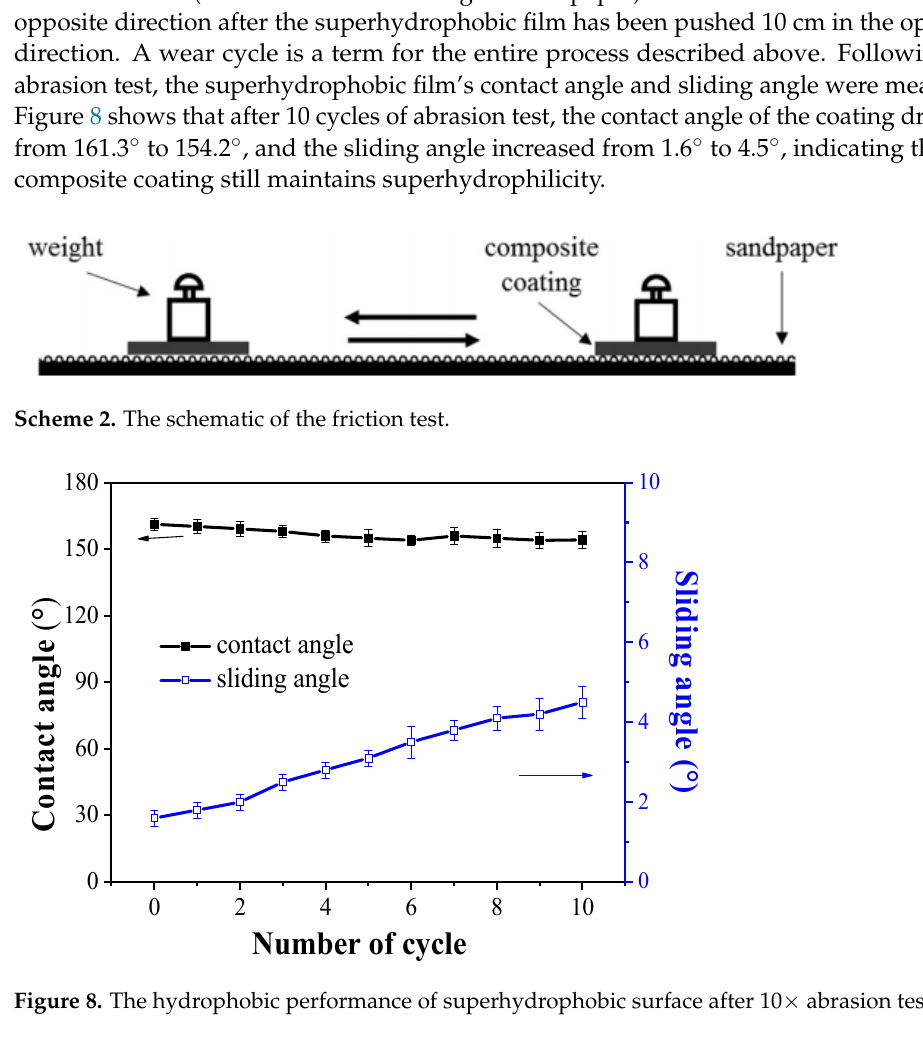
Figure 8. The hydrophobic performance of superhydrophobic surface after 10× abrasion testing.